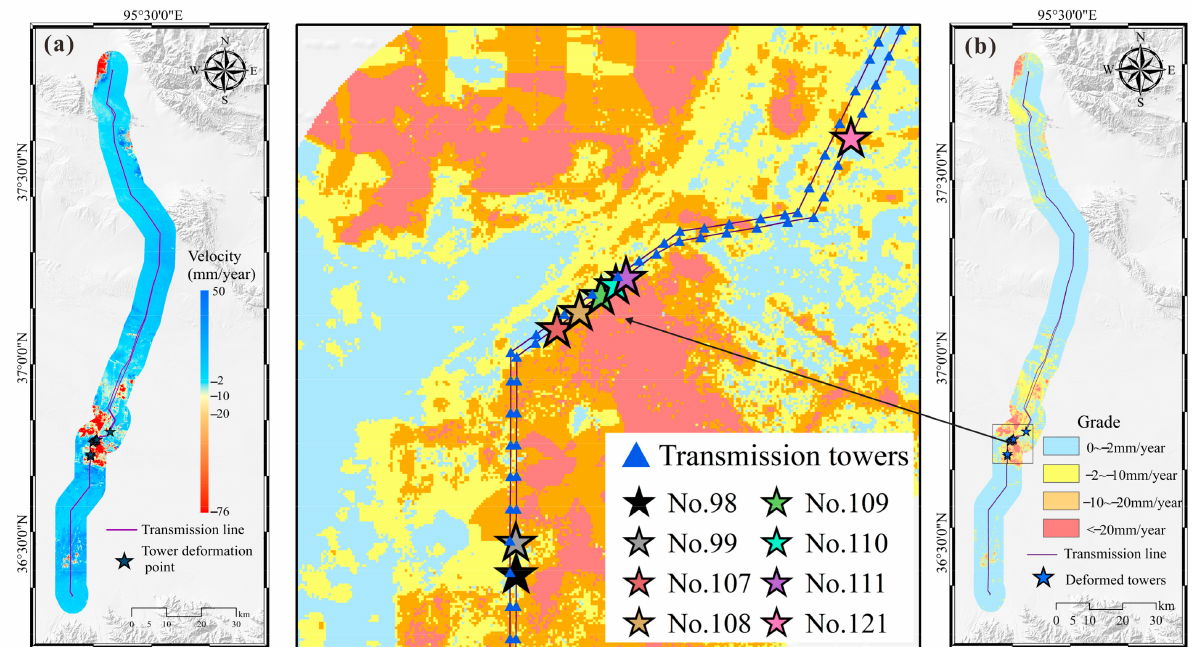
Figure 8. ( a ) Kriging interpolation is carried out from the vertical deformation map to obtain the deformation map of the whole area; ( b ) the distribution of different land subsidence